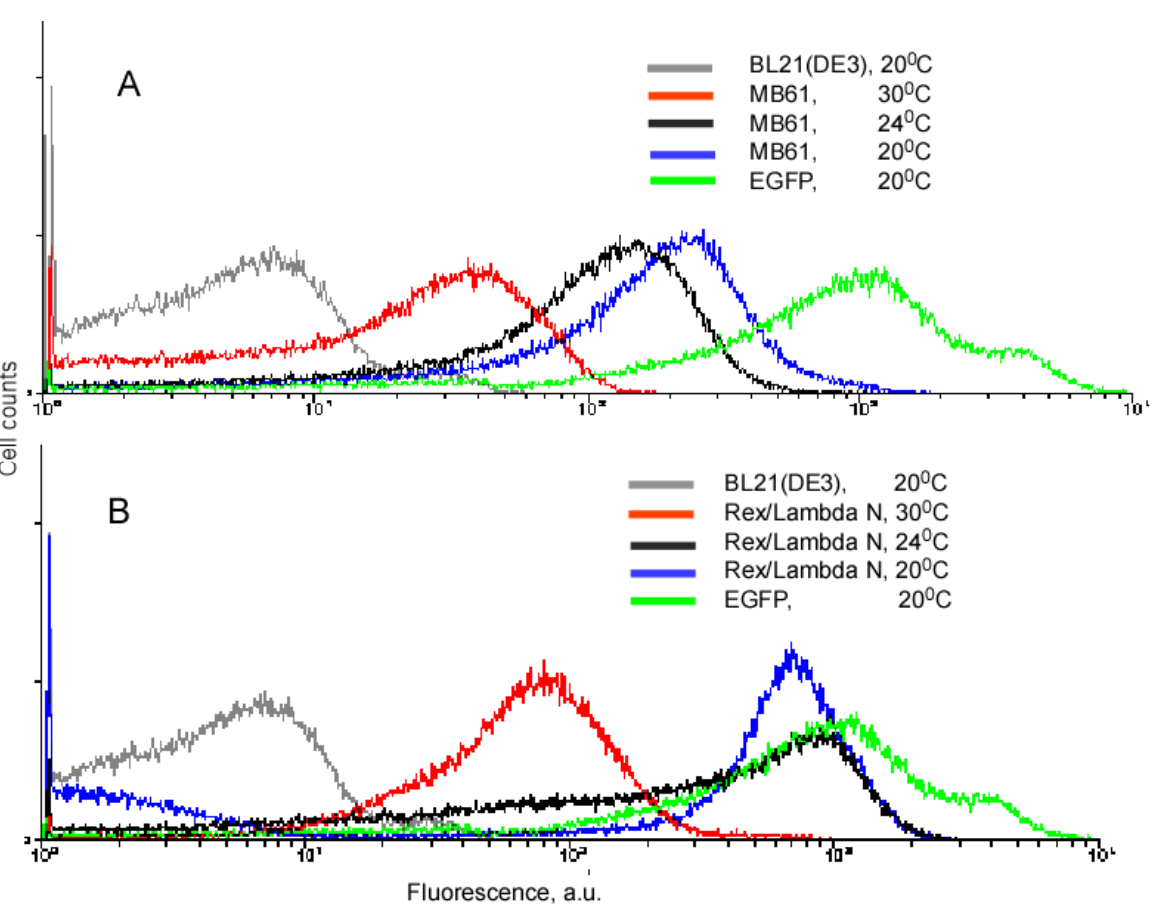
Figure 3. Background fluorescence in E. coli cells expressing protein fusions can be regulated by the temperature of cell culturing. ( A ). E. coli MB61 cells express two fusion proteins α -F1 and β -F2, fragments of EGFP and eIF4A proteins. Two fusion proteins were cloned in the vector pACYCDuet 1 and induced with 1 mM IPTG at different temperatures. Fluorescence of the E. coli cells BL21(DE3) and the cells expressing intact EGFP from the same vector is shown for comparison; ( B ). Rex/Lambda N denote E. coli cells which express two fusion proteins containing fragments of split EGFP fused to HTLV-1 Rex and lambda N peptides. The protein fusions were cloned into the plasmid pACYCDuet 1 and induced with 1 mM IPTG at different temperatures. Fluorescence of the E. coli cells BL21(DE3) and the cells expressing intact EGFP is shown for